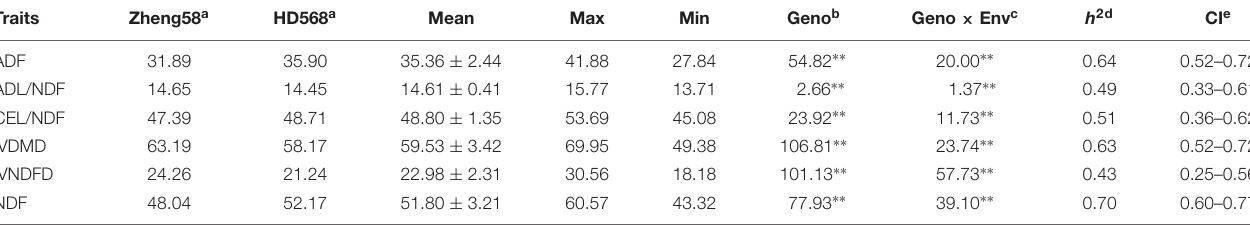
TABLE 1 | Phenotypic variation of cell wall components and digestibility traits in the RIL population.